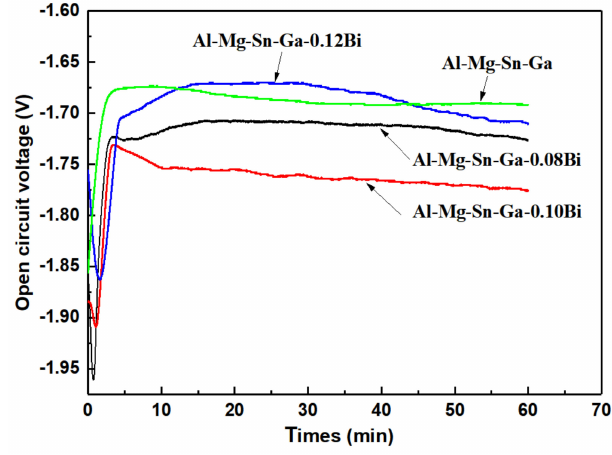
Figure 6. Open circuit voltage curves of Al-Mg-Sn-Ga-xBi